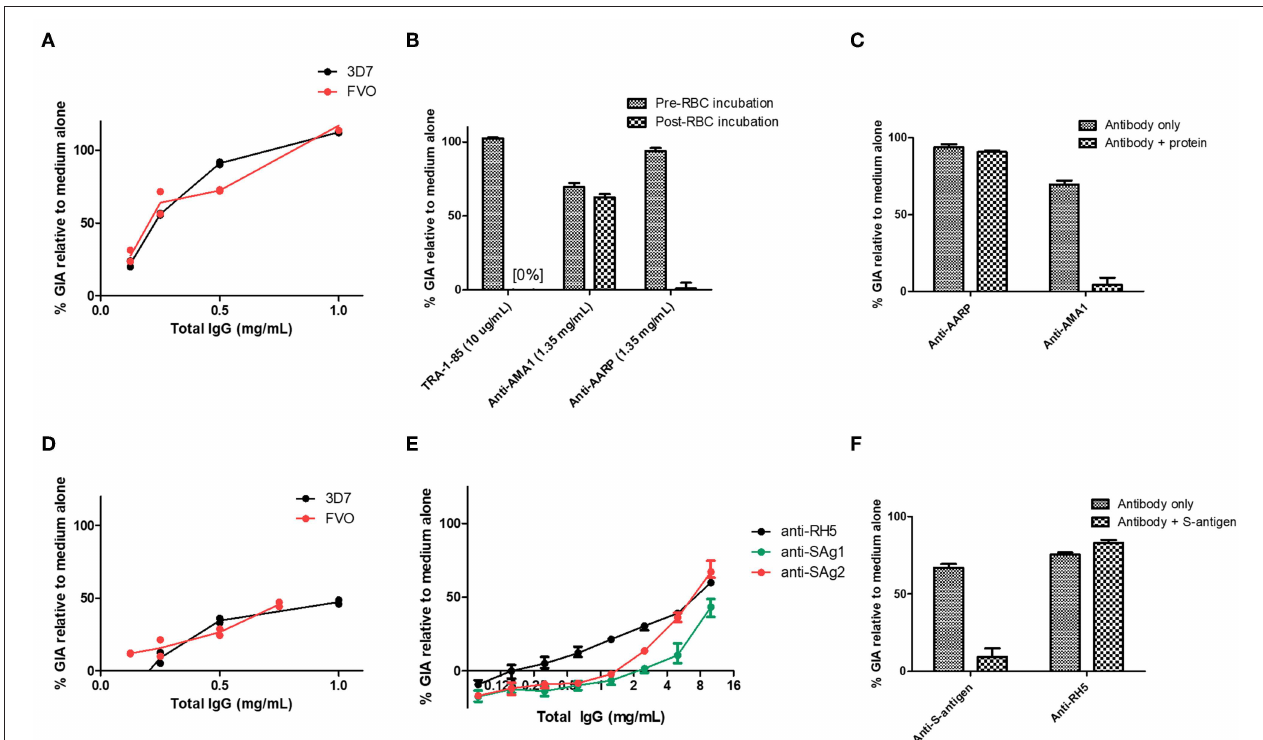
FIGURE 4 | Functional activity of anti-S-antigen and anti-AARP antibodies in the assay of GIA. (A) Titration of the same anti-AARP-BAP-Strep sample shown in Figure 3B against the 3D7 clone and FVO strain. (B) Effect of RBC pre-incubation on a range of mouse antibody specificities. TRA-1-85 is a mouse anti-basigin monoclonal antibody. Other samples are total IgG from immunized mice (see Figure S3 for further details). (C) Pre-mixing of the relevant immunizing antigen with mouse total IgG. Final antigen concentration was 1.35 mg/mL, IgG concentration was 1 mg/mL. (D) Titration of the same anti-S-antigen-BAP-Strep sample shown in Figure 3B against the 3D7 clone and FVO strain. (E) Total IgG from two Zika rabbits immunized with S-antigen-BAP-Strep formulated with Freund’s adjuvant system. Samples were subjected to pre-depletion with RBCs. (A–D) are each from a single GIA assay run due to sample volume constraints. (A,D) , lines are connected mean and points individual replicate wells (two per concentration). (F) Pre-mixing of S-antigen protein with pooled rabbit total IgG from (E) . Final S-antigen concentration was 1.5 mg/mL, total IgG concentration was 10 mg/mL. (A–D) , mean and range of four replicates. (E,F) , mean and range of three wells of a single GIA assay, representative of data from two replicate GIA assay